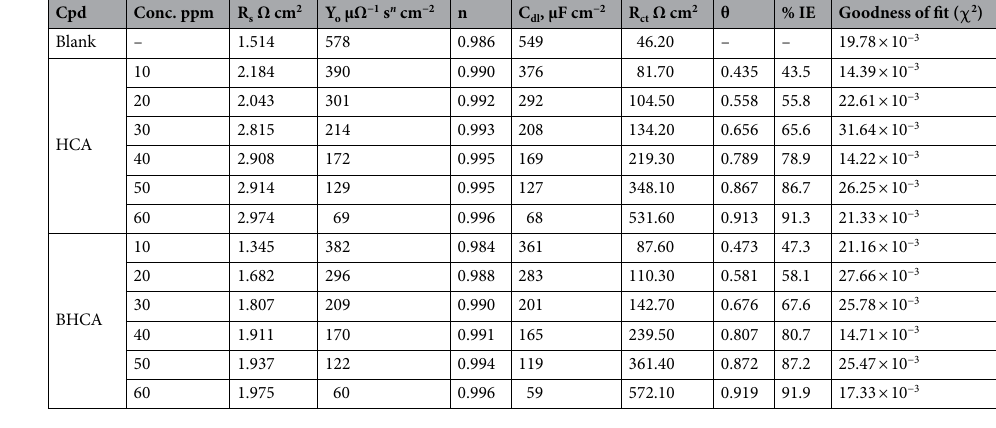
Table 7. EIS data of CS in 1 M HCl in the absence and presence of altered doses of HCA and BHCA at 298 K.